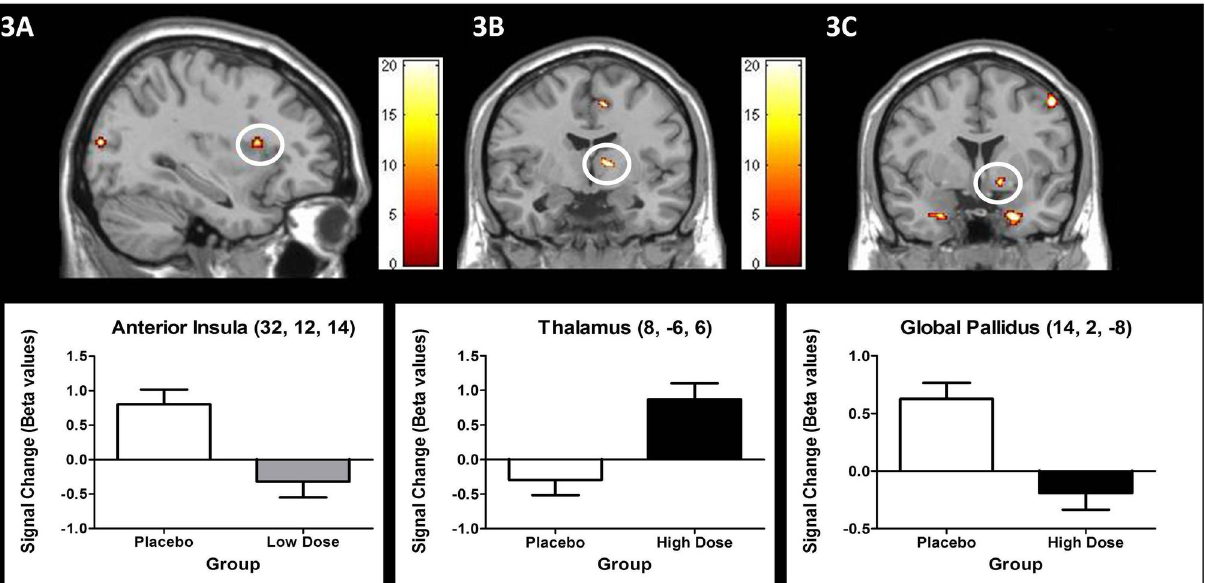
Figure 3. Activations arising from the planned group comparison 2nd- level models (thresholded at p < 0.005, k = 13; scale represents F statistic; see results section for details). Comparison of the Sstop>Go contrast between the low-dose and placebo groups (Figure 3A), and the high-dose and placebo groups (Figure 3B and 3C). doi: